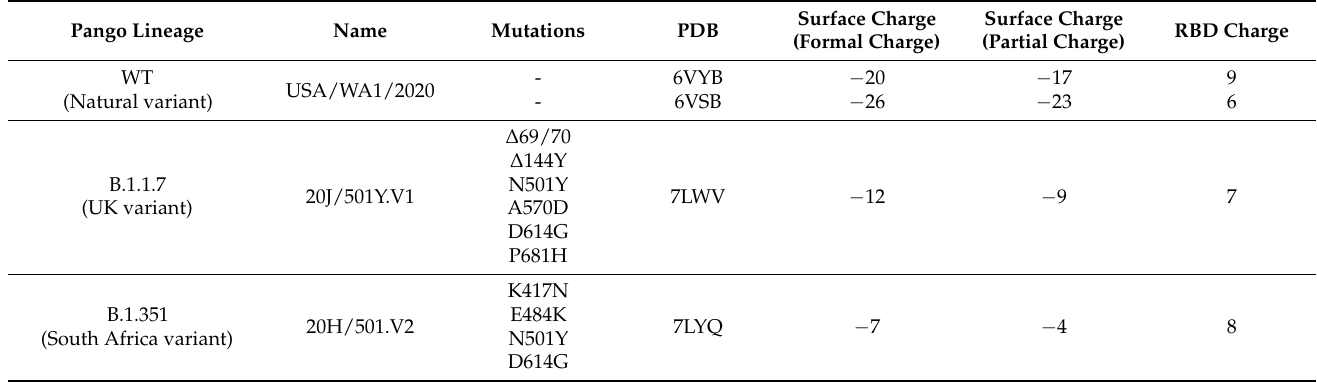
Table 2. Comparison of surface charge on S protein of the two VOI with the wild type at pH 7.0. Pango